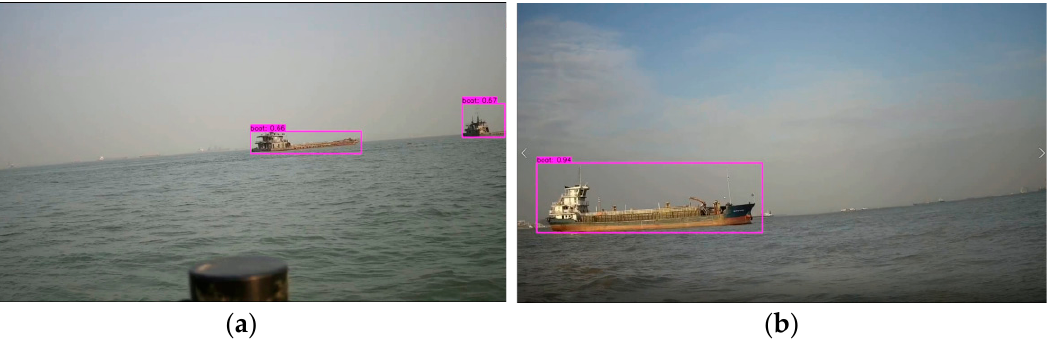
Figure 9. Target detection results of tilted images in actual scenes. ( a ) Tilted images 1 in actual scenes. ( b ) Tilted images 2 in actual scenes.